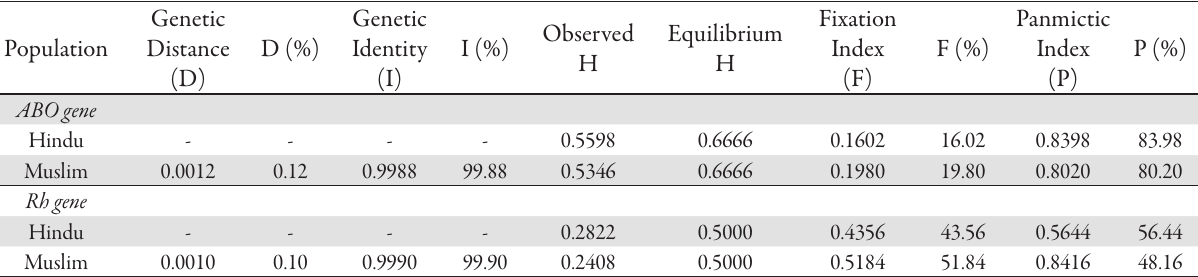
Tab. 4. Estimates of genetic distance, identity, fixation index and panmictic index between Hindus and Muslims of Barak Valley for ABO and Rh